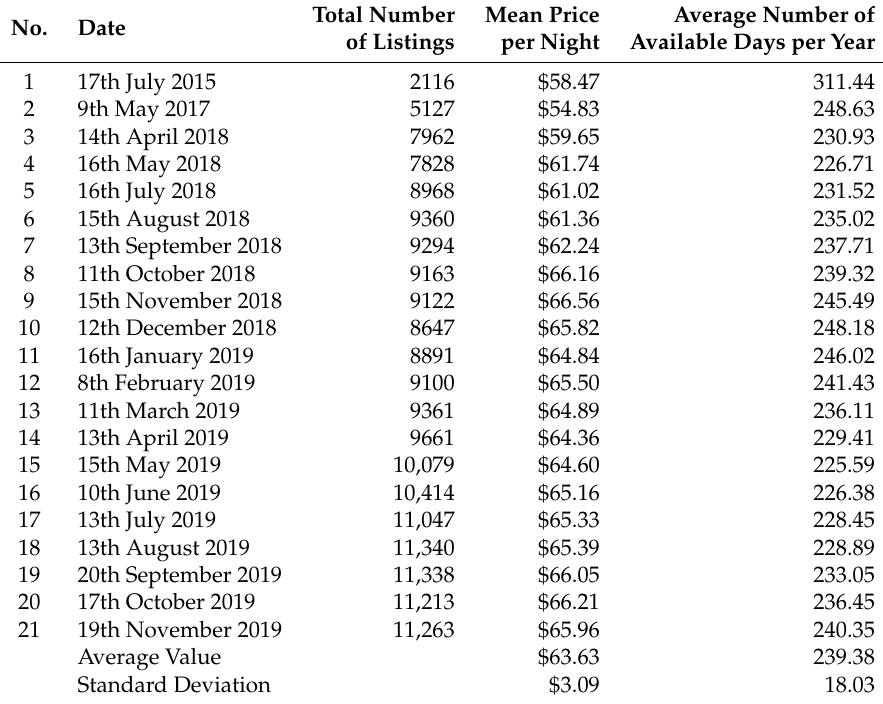
Table 1. Characteristics of Inside Airbnb data dumps of Athens, Greece.